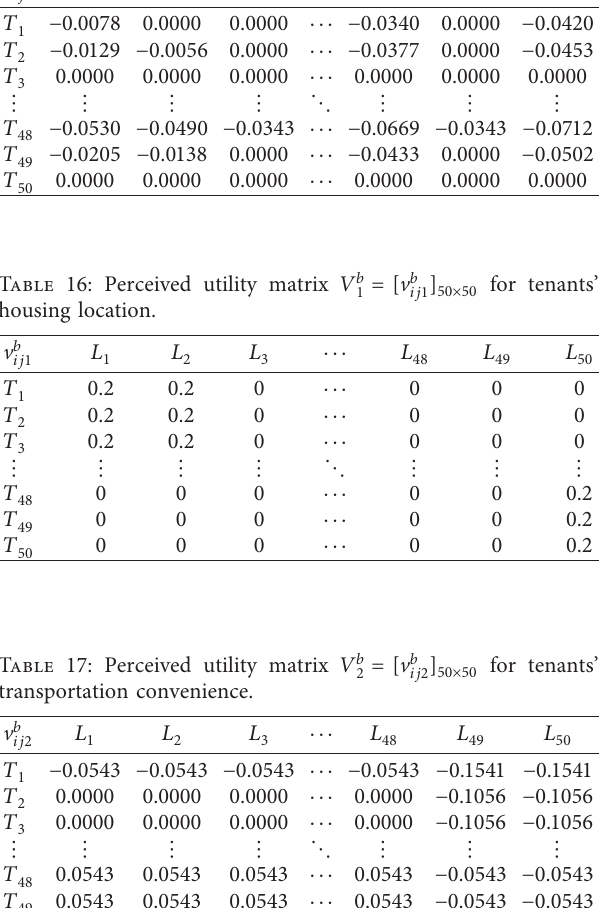
� [ v s ] for landlords’ ij 2 50 × 50 2